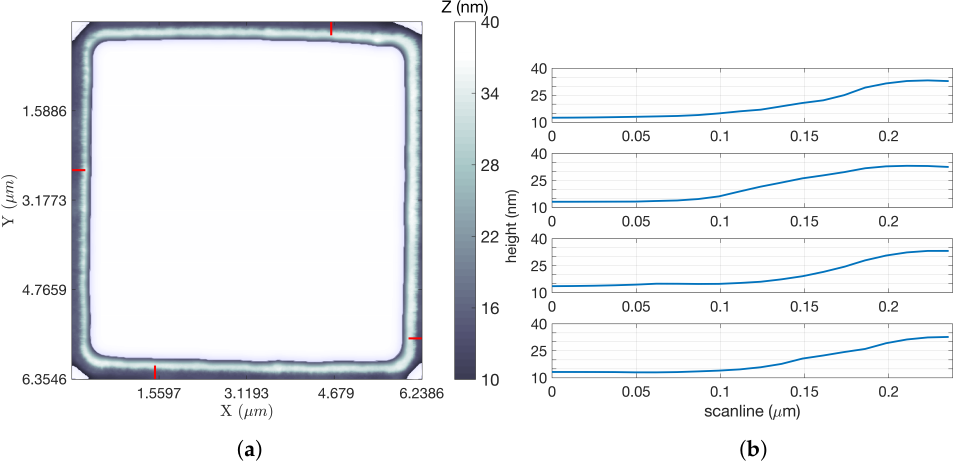
Figure 5. Square grating results. ( a ) LCS image. The white background indicates no information (LCS z image, ω = 20 Hz); ( b ) Two hundred and ten nanometer-long (17 pixel) line scans generated from along each of the four red lines shown on the LCS image, starting from the top of the rectangle and proceeding clockwise. All scans were directed outside to inside and showed step heights of (from top line scan to bottom) 20.7, 20.0, 19.6 and 19.7 nm (line scans along red lines in ( a